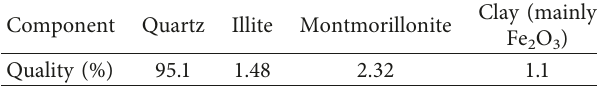
Table 1: Quality percentage of sandstone’s mineral component.